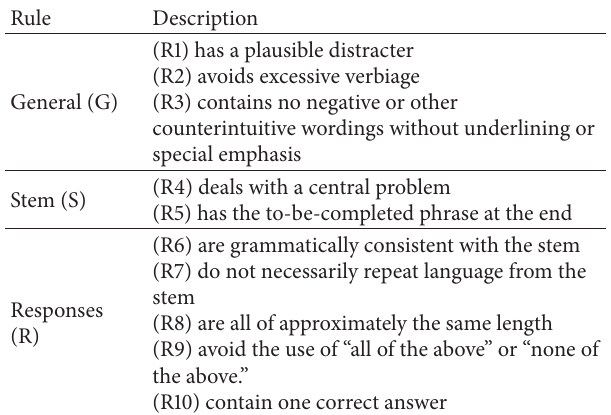
Table 4: MCQ design rules.